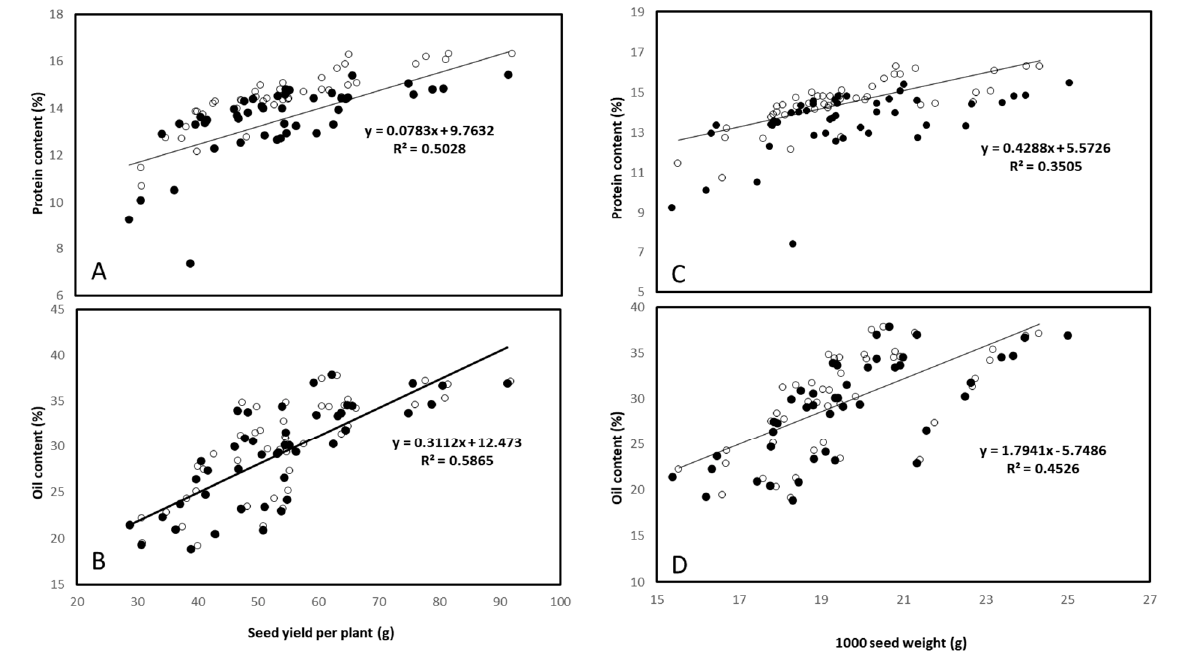
Figure 9. Seed protein and oil content as a function of seed yield per plant (( A ) and ( B ), respectively) and of 1000–seed weight (( C ) and ( D ), respectively) in five milk thistle ecotypes (‘Ahvaz’, ‘Budakalazi’, ‘Khomin’, ‘Khoram Abad’, and ‘Sari’), cultivated under the application of chitosan or TiO 2 treatments (bulk, nanoparticles) at three concentrations (0, 50, and 100 mg L –1 ). Data of all ecotypes and treatments were pooled across years (Year 1, open symbols; Year 2, closed symbols).